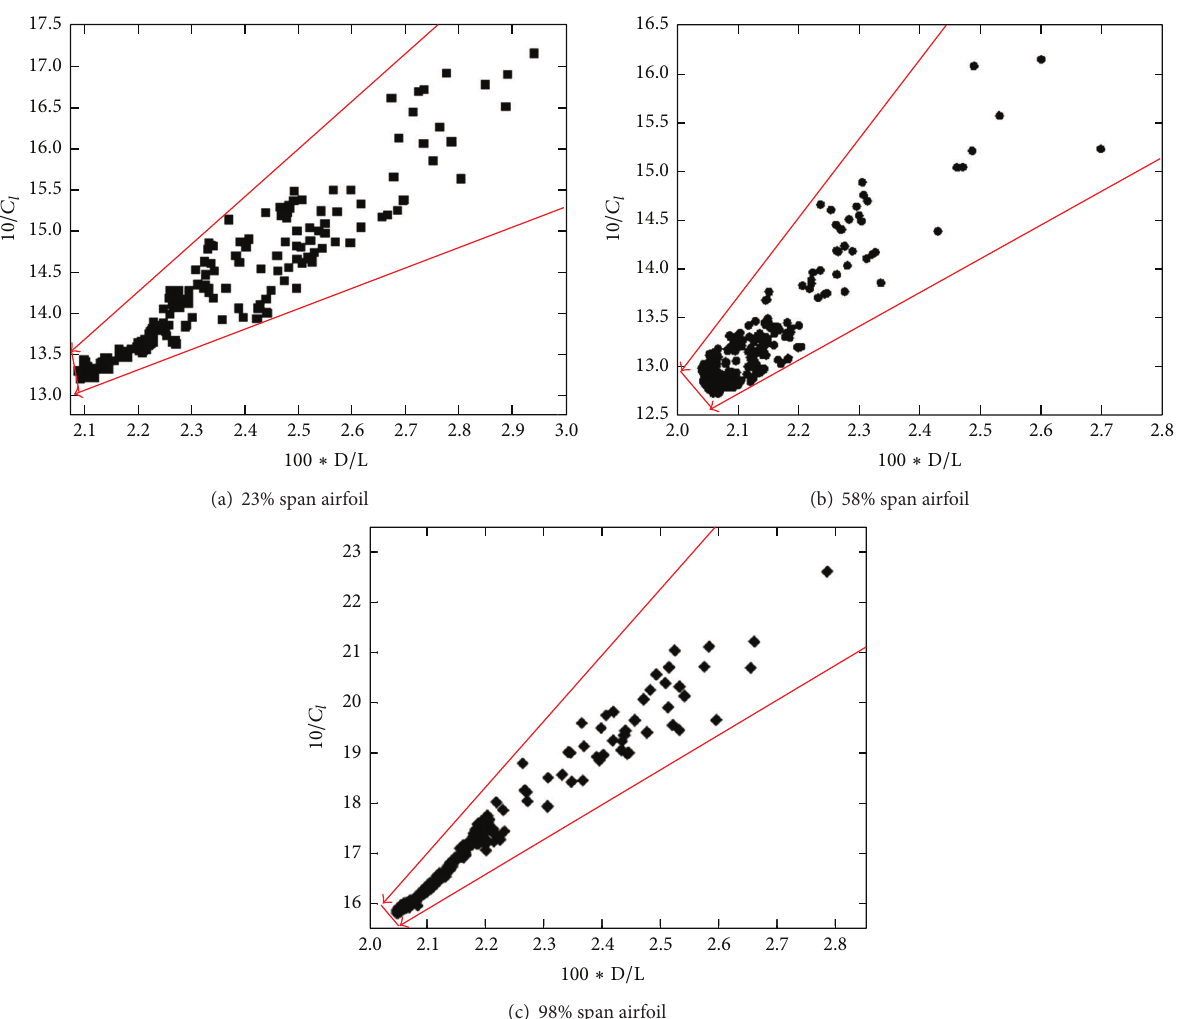
Figure 10: Dominated solutions in Pareto front approximation for airfoils at 23%, 58%, and 98% span locations.